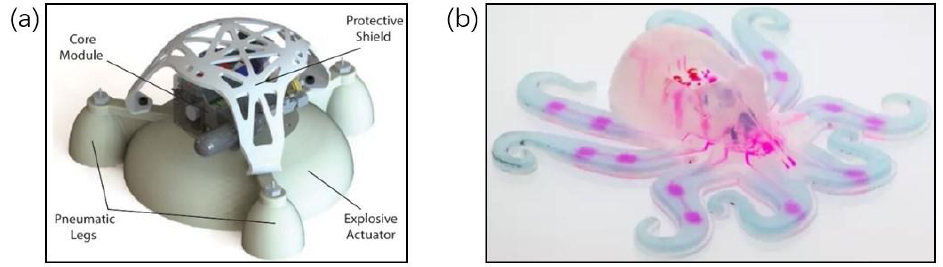
Figure 7. ( a ) Computer-aided design model of the entire robot [74]. ( b ) Fully soft, autonomous robot, Octobot [76]. Octobot